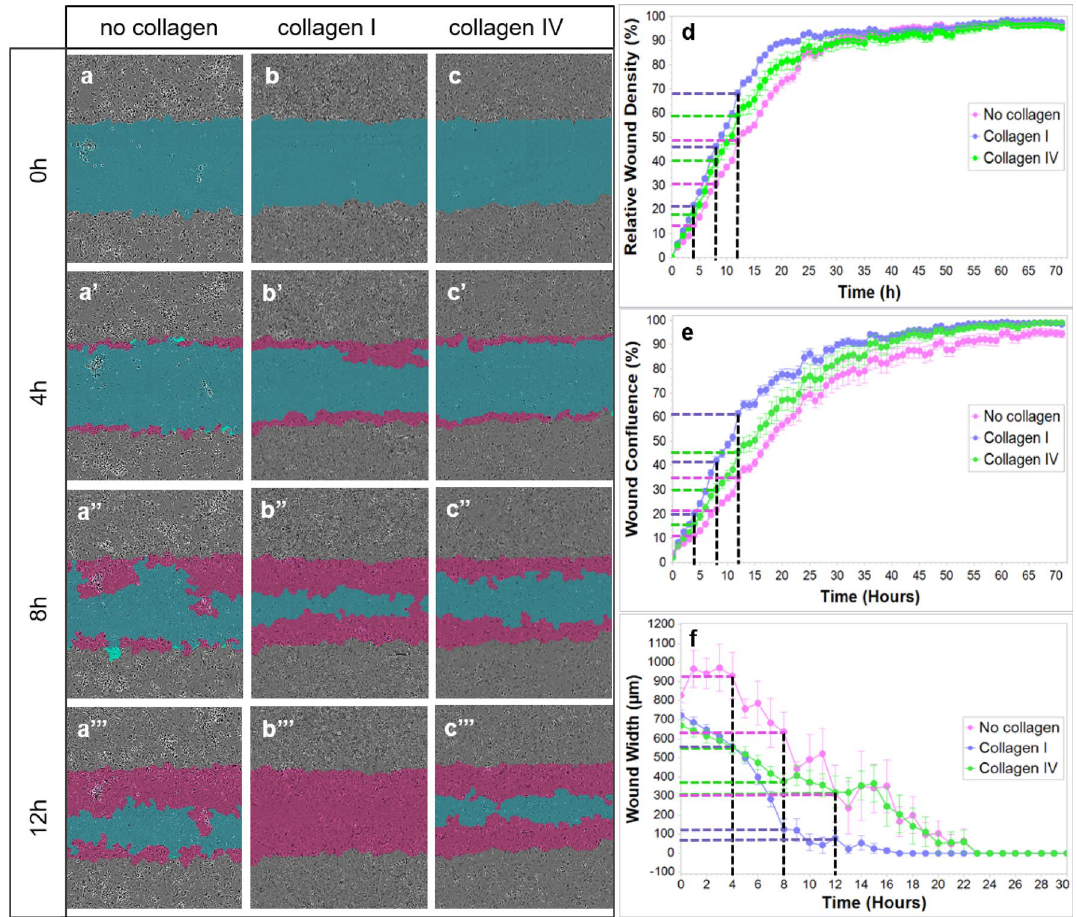
Figure 8. In vitro ECs migration on collagen I and collagen IV substrates. The blue region denotes the scratch wound mask over time (0 h, 4 h, 8 h, and 12 h). ECs migrate into the wound area on non-coated ( a ), collagen I-coated ( b ) and collagen IV-coated wells ( c ). The red area depicts the wound closure by EC expansion over time. The most effective and fast EC migration is observed with the collagen I substrate, followed by collagen IV and lastly, the least efficient, non-coated wells at 0, 4, 8, and 12 h ( a – c’’’ ; d , e , and f ). Relative wound density ( d ), wound confluence ( e ) and wound width ( f ) has been quantified. Cells in the wound area are the most confluent in collagen I-coated wells, followed by collagen IV and non-coated wells ( e ). Blue dashed line - collagen I, green dashed line - collagen IV, purple dashed line - no collagen, black dashed line - time points (4 h, 8 h, 12 also important for lumen formation 40 . Therefore, we decided to investigate collagen I using a specific transgenic zebrafish line (fli:eGFP//colRN:mcherry-NTR), by which we are able to reduce the amount of collagen 1α2 during caudal fin regeneration. Firstly, we demonstrated that NFP treatment causes ablation of collagen 1α2-producing cells independently of the fin wound closure (Supplementary Fig. S3 online) and only together with the NTR system (Supplementary Fig. S4 online). Due to the treatment, active cells producing collagen 1α2 fibers are absent (Figs. 6 and 7) resulting in strongly reduced levels of collagen 1α2 fibers (Fig. 7). In vivo observation revealed a deficiency in collagen 1α2-producing cells, shorter regeneration area and an underdeveloped vascular plexus (Figs. 6 and 7). The amputation plane was damaged and accommodates cell debris, apoptotic and disintegrated cells. Intercellular space contained atypical and amorphous ECM with less CFs. Blood vessels are partially covered by ECs and bleeding was observed as cluster of RBCs. Higher numbers of MΦ and Gr were present as expected for clearing tissue debris (Fig. 7). TRA and VPA decreased during the first 10 days of regeneration, meaning the growth delay and vascularization were impaired. We believe that the collagen I scaffold, which traces the direc- tion of blood vessel expansion, is insufficient therefore preventing ECs from expanding properly and impairing angiogenesis and regeneration. In comparison to BAPN treatment, here the effects were not as severe, likely due to the fact that only one type of collagen, among many present in ECM, was targeted. In both cases, manipulation of CFs results in impaired fin regeneration and angiogenesis, but the dramatic angioma-like phenotype is related to the inhibition of collagen crosslinking. We speculate that the balloon-like structures are formed due to impaired collagen IV and abnormal BM. Collagen I likely serves as a scaffold and specific disruption of collagen I (NFP) results in shortened capillary segments. Collagen IV, as a part of the BM, is important for vascular integrity and normal lumen formation. By over-all collagen cross-linking inhibition, in